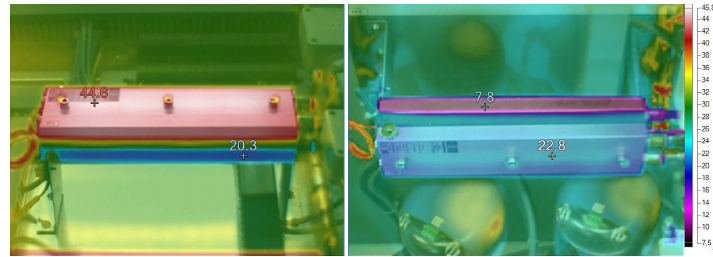
Figure 7. Technical issue—thermographic